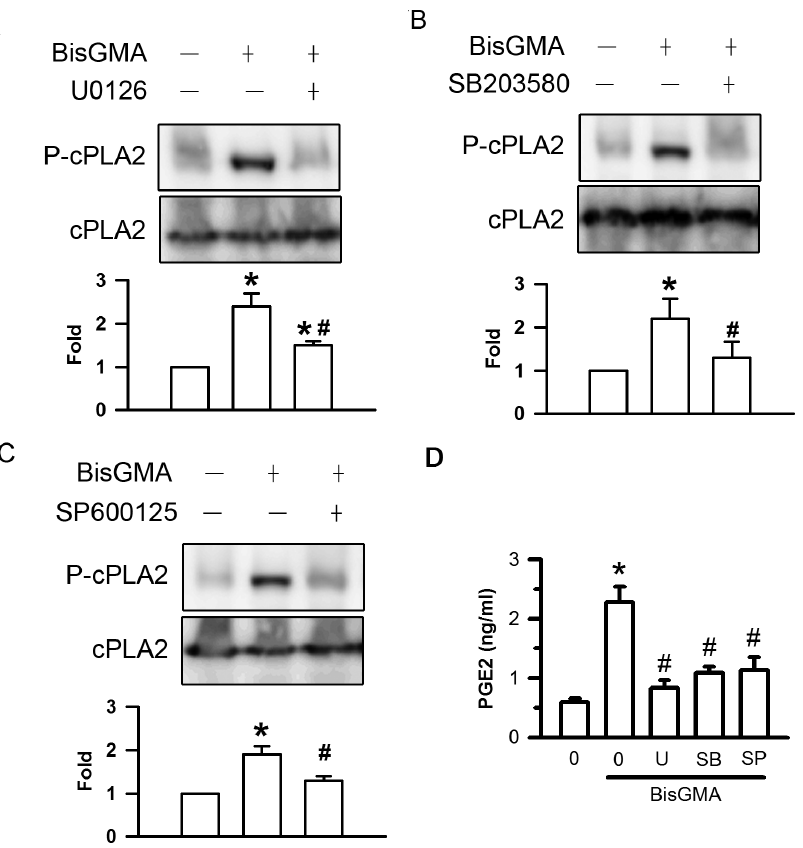
Figure 8. Effects of U0126, SB203580, and SP600125 on BisGMA-induced cPLA2 phosphorylation and PGE2 generation. After treatment with 1 m M U0126 (A), 30 m M SB203580 (B), and 30 m M SP600125 (C) for 30 min, RAW264.7 macrophages were stimulated with 3 m M BisGMA for 2 h. Cells were harvested and protein extracts were subjected to SDS-PAGE Western blot analysis using antibodies against the phosphorylated and total ERK1/2, p38, and JNK. The ratio of immunointensity between the phosphorylation and total protein was calculated. (D) The supernatant was harvested and detected by ELISA assay of PGE2. (D) The supernatant was harvested and detected by ELISA assay of PGE2. Values are expressed as means 6 S.D. ( n= 3 in each group). *represents significant difference from control values with p , 0.05. # represents significant difference from BisGMA values with p , 0.05.